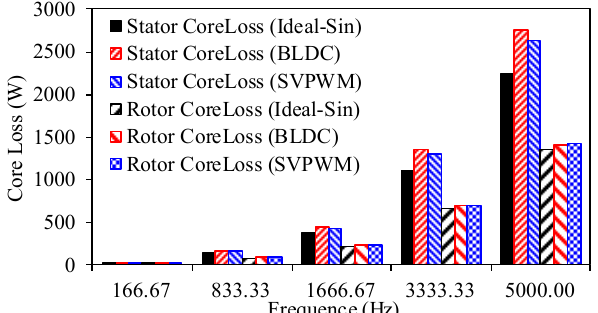
Figure 7. Core losses of the stator and rotor under three driving methods.